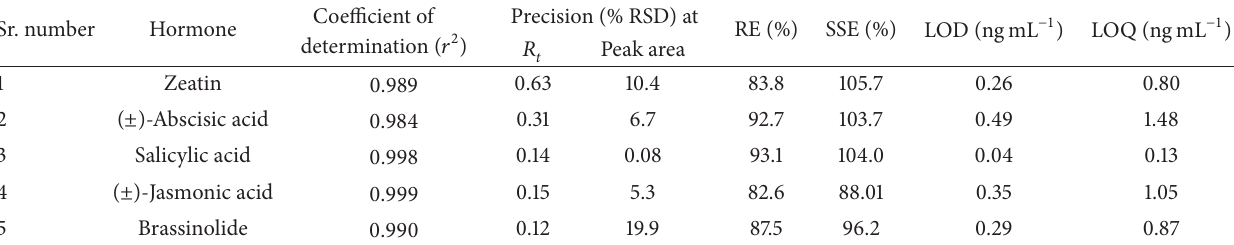
Table 2: Overview of validated parameters ( 𝑅 𝑡 , retention time; LOD, limit of detection; LOQ, limit of quantification; RE, recovery in percent; RSD, relative standard deviations; and SSE, signal suppression/enhancement).